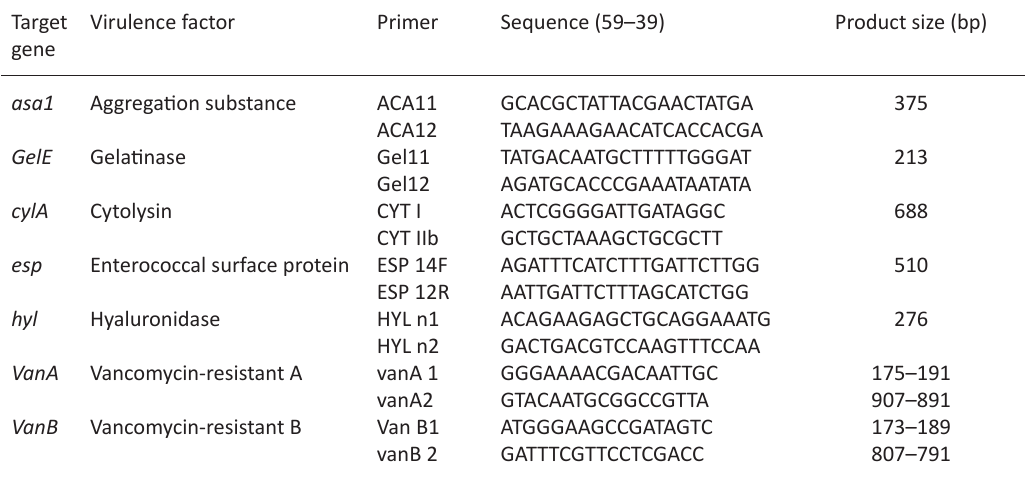
Table 1. Primers utilized in the RT-PCR for E. faecalis detection Target Virulence factor